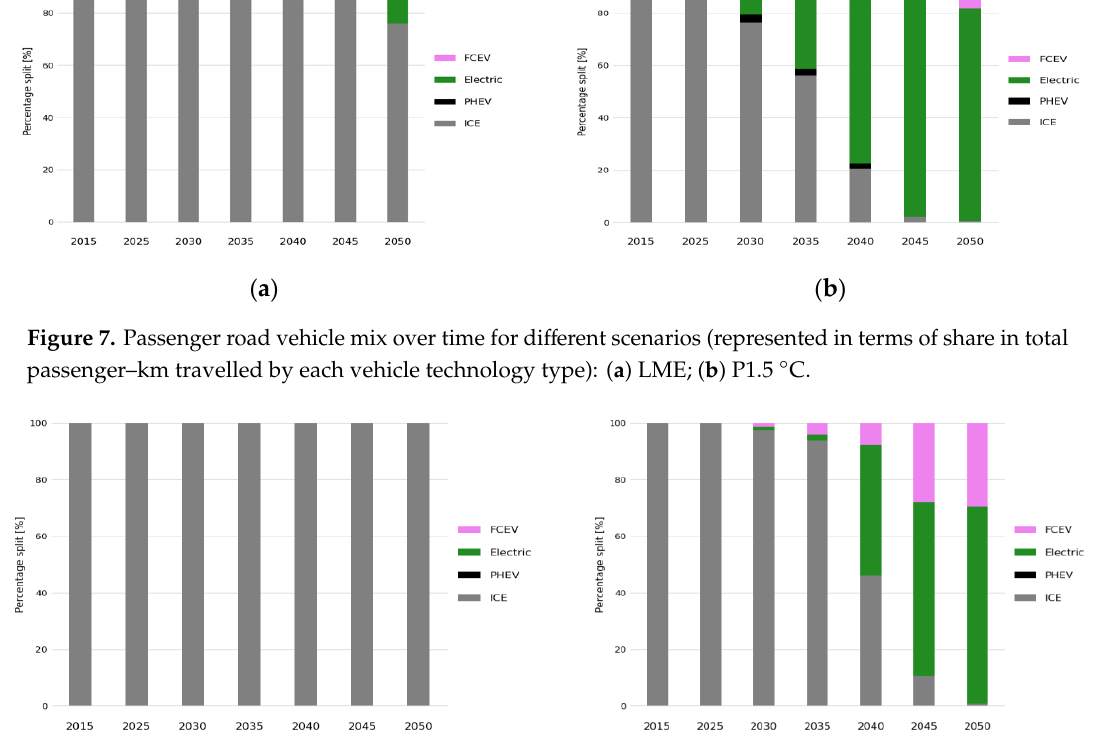
Figure 7. Passenger road vehicle mix over time for different scenarios (represented in terms of share